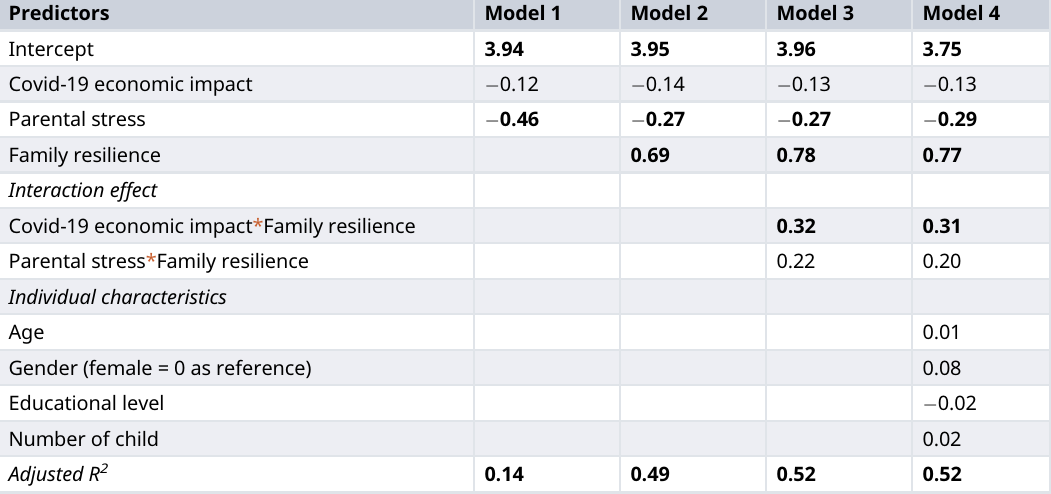
Table 4. Conditional effect of family resilience on the relation between predictors and FQOL (N = 158), with standard error in parentheses. Predictors